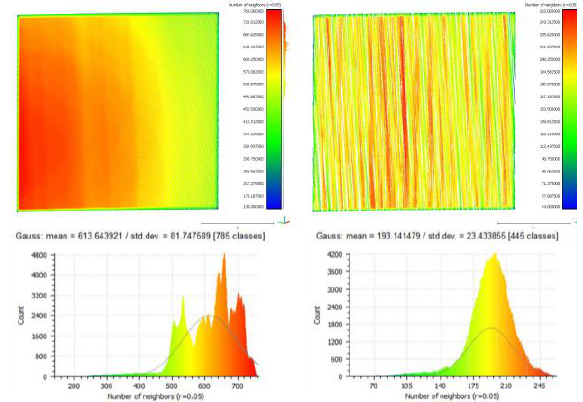
Figure 10. Analysis of a wall portion as planar surface: density comparison between TLS (left) and MMS (right). The analysis has been performed using CC (number of neighbour analysis, pts/V sphere r = 0.05 m).